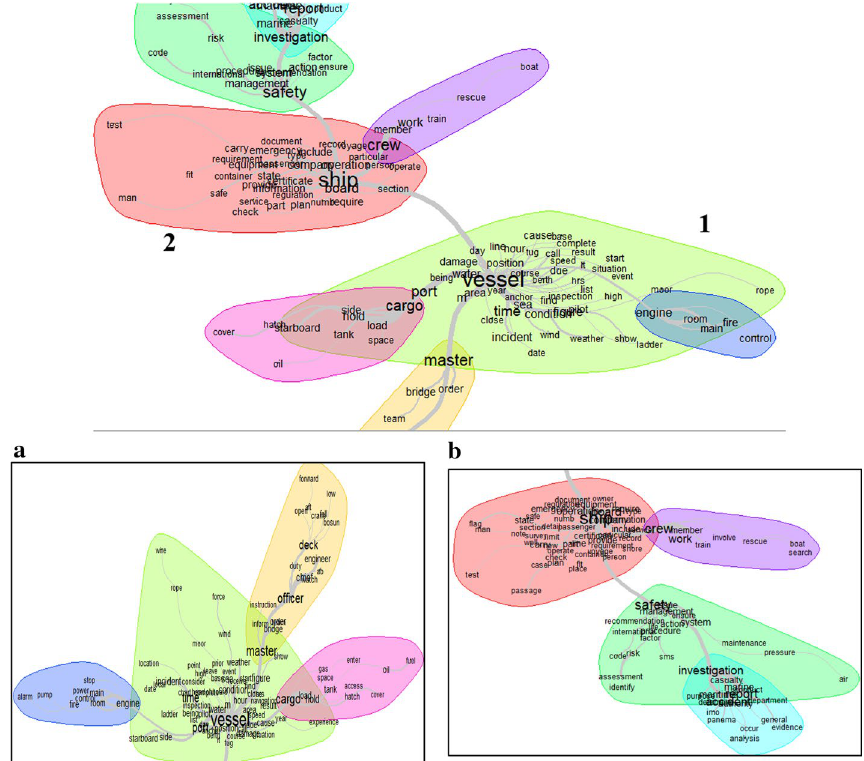
Fig. 3 IRAMUTEQ analysis of Similarities of IMO dataset (based on co‑occurrences of 143 most frequent words). Source: The authors. a Universe of words around the term “vessel” from the IRAMUTEQ Analysis of similarities in IMO dataset. b Universe of words around the term “ship” from the IRAMUTEQ Analysis of similarities in IMO